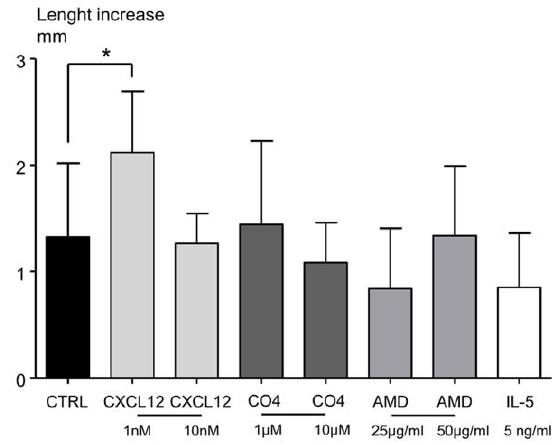
Figure 6. CXCL12 has direct effect on worm growth invitro . Length of filariae (mm) was measured before and after 5 days of in vitro culture. Groups of filariae were constituted and treated with either CXCL12 (1 nM, 10 nM), Chalcone C04 (C04, 1 m M, 10 m M), AMD3100 (AMD, 25, 50 m g/ml) or IL-5 (5 ng/ml). Treatments were added daily to wells containing two filariae in 1 ml, as detailed in Materials and Method. Length increase was expressed as median 6 interquartile range of 30 filariae for control group (Ctrl, medium only), 20 for other groups, and 10 for the IL-5 treated group. The differences between treatments were analysed by a non parametric Kruskall-wallis test followed by Dunn’s multiple comparison test, with control group as reference. ‘‘*’’ marks significant differences between treated filariae and the control group (*p , 0.05).